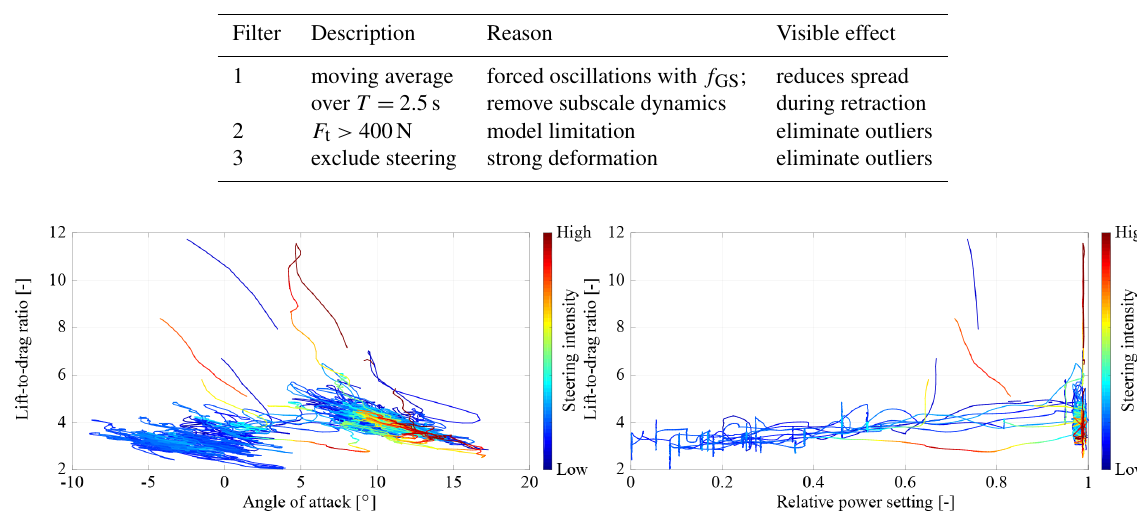
Table 2. Three filtering procedures applied to the measured lift-to-drag ratio.